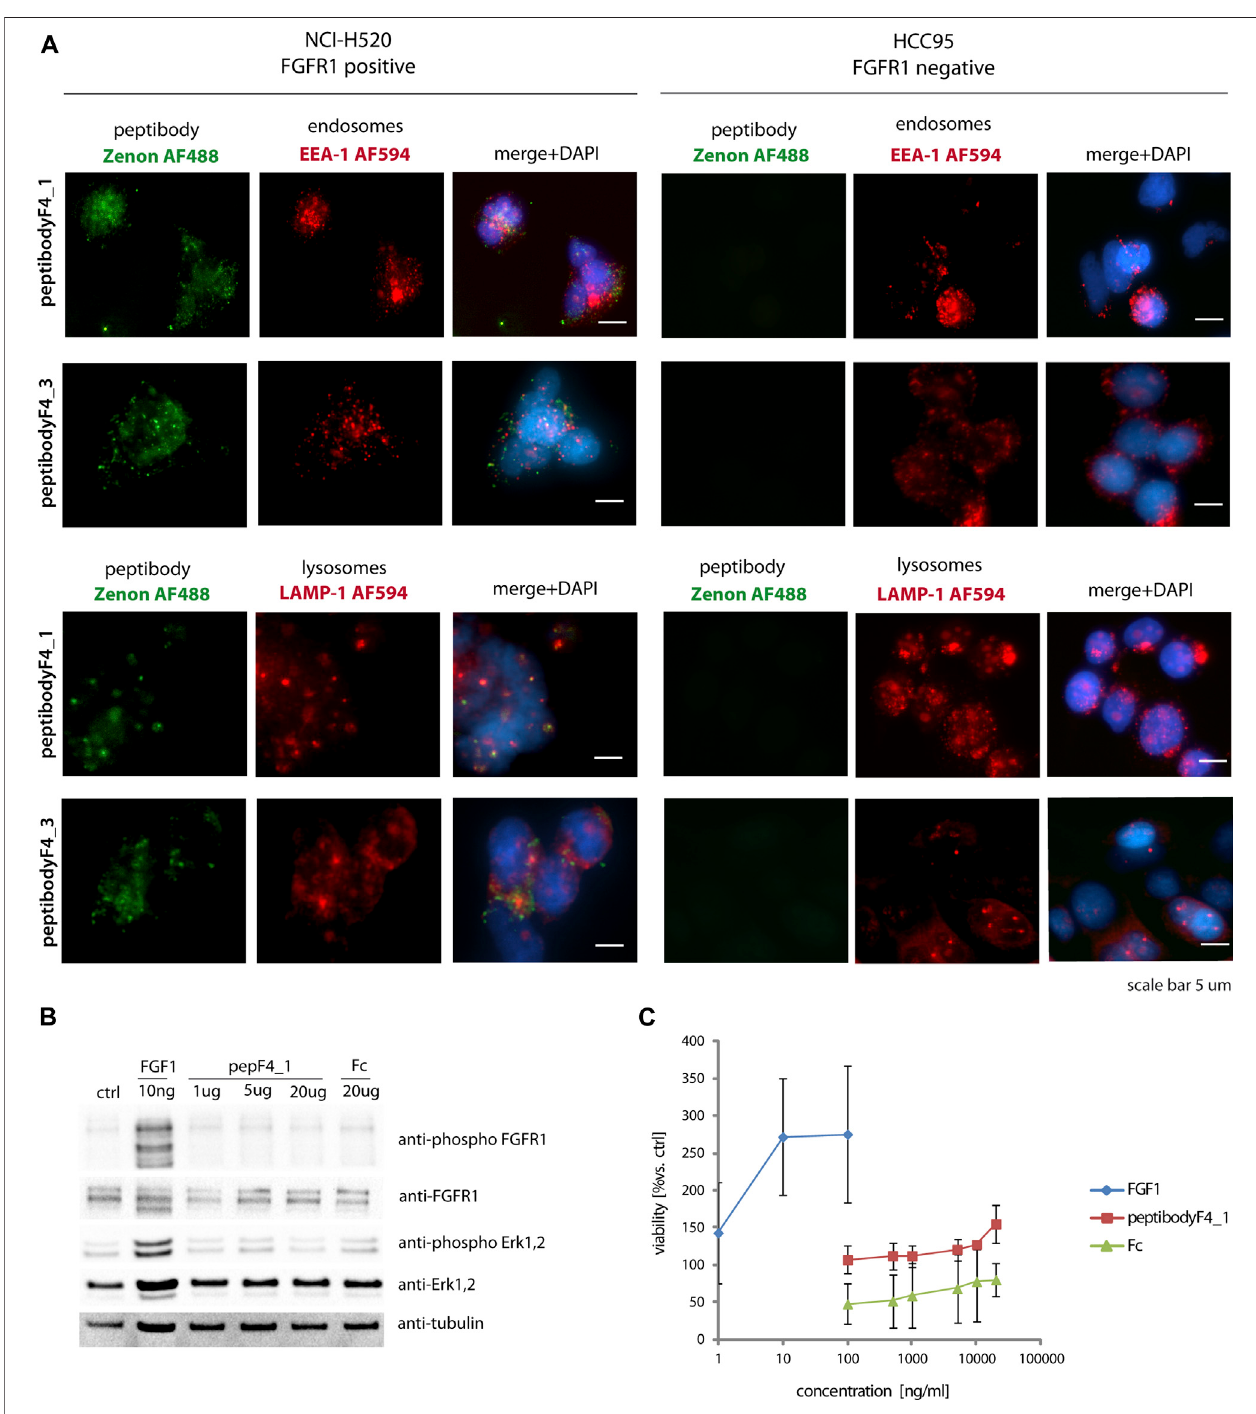
FIGURE 4 | PeptibodyF4_1 internalization via FGFR1-dependend endocytosis. (A) NCI-H520 (FGFR1-positive cells) and HCC95 (control cells) were incubated with peptibodyF4_1 or peptibodyF4_3. Early endosomes were labeled with anti-EEA-1 (red), lysosomes with anti-LAMP1 (red), peptibodyF4_1 internalized was visualized with Zenon-AF488 reagent, and nuclei ware stained with NucBlue reagent. Experiments were performed in three independent replicates. (B) PeptibodyF4_1 binding to FGFR1 does not activate FGFR1 and downstream kinases. Activation of FGFR1 and Erk1, 2 kinases after addition of peptibodyF4_1 to NIH 3T3 fi broblastsweretestedwithwesternblot. (C) PeptibodyF4_1doesnotcauseNIH3T3 fi broblastsproliferationafter48 htreatment.FGF1wasused asapositivecontrol.